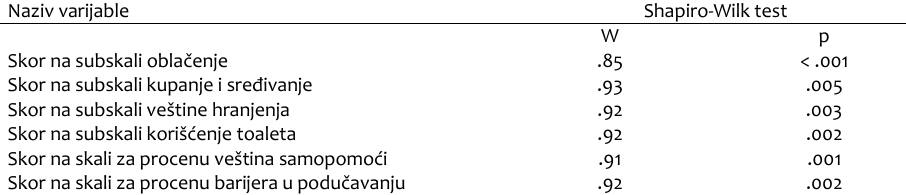
Tabela 3. Rezultati Shapiro-Wilk testa normalnosti